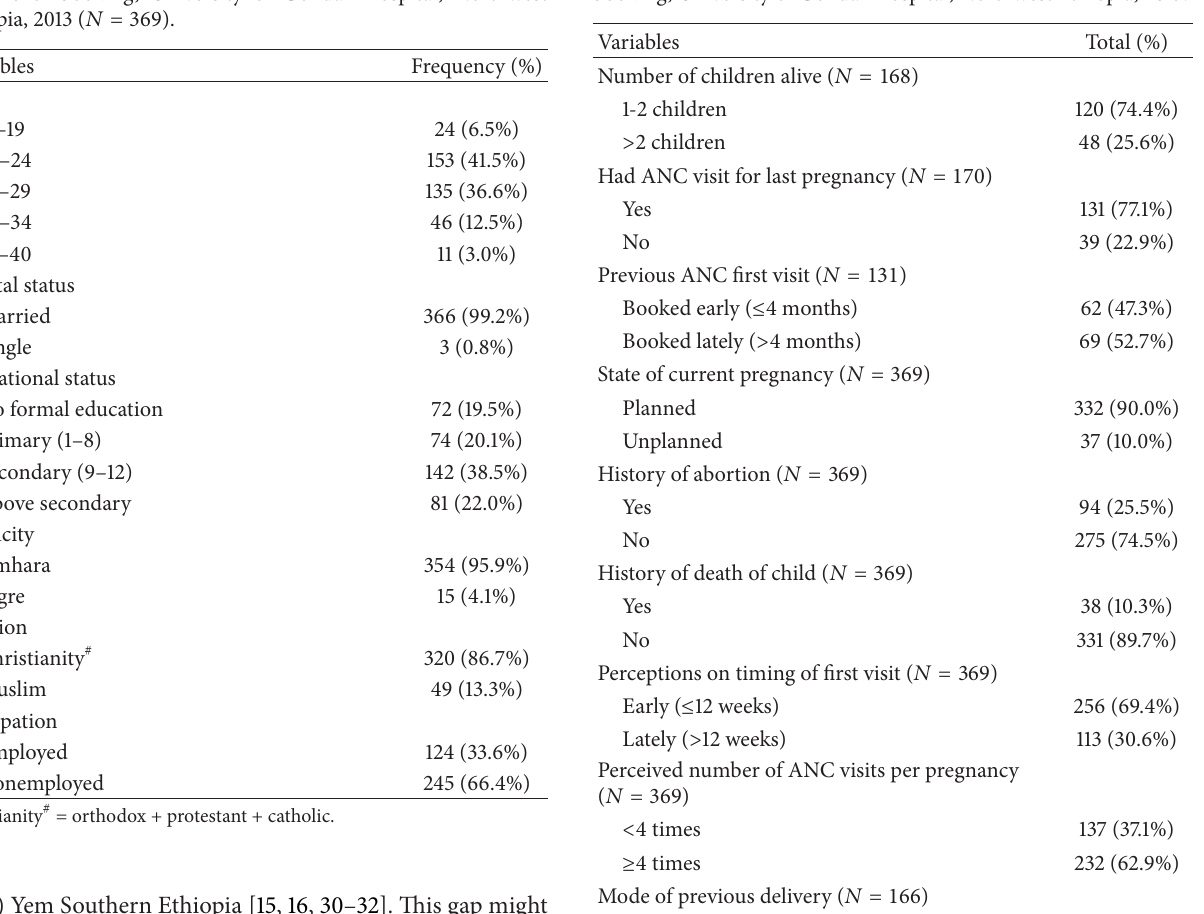
Table 2: Obstetric characteristics of pregnant women by time of booking, University of Gondar Hospital, Northwest Ethiopia,